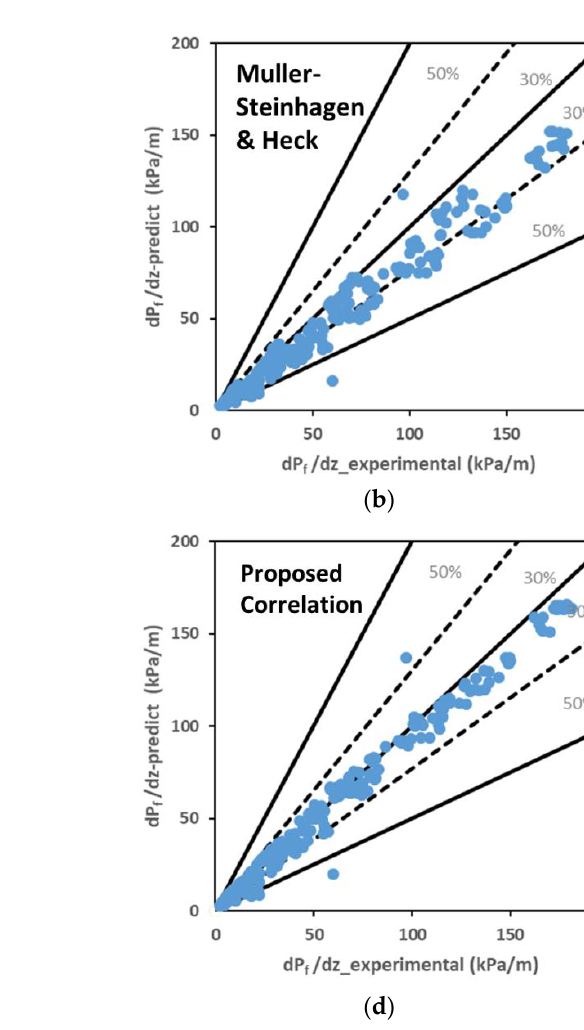
Figure 10. ( a ) Performance of Lockhart–Martinelli, ( b ) Muller–Steinhagen and Heck, ( c ) Friedel, and ( d ) proposed modified Muller–Steinhagen and Heck correlations. Table 6. Evaluation of heat transfer coefficient correlation. Table 6. Evaluation of heat transfer coefficient